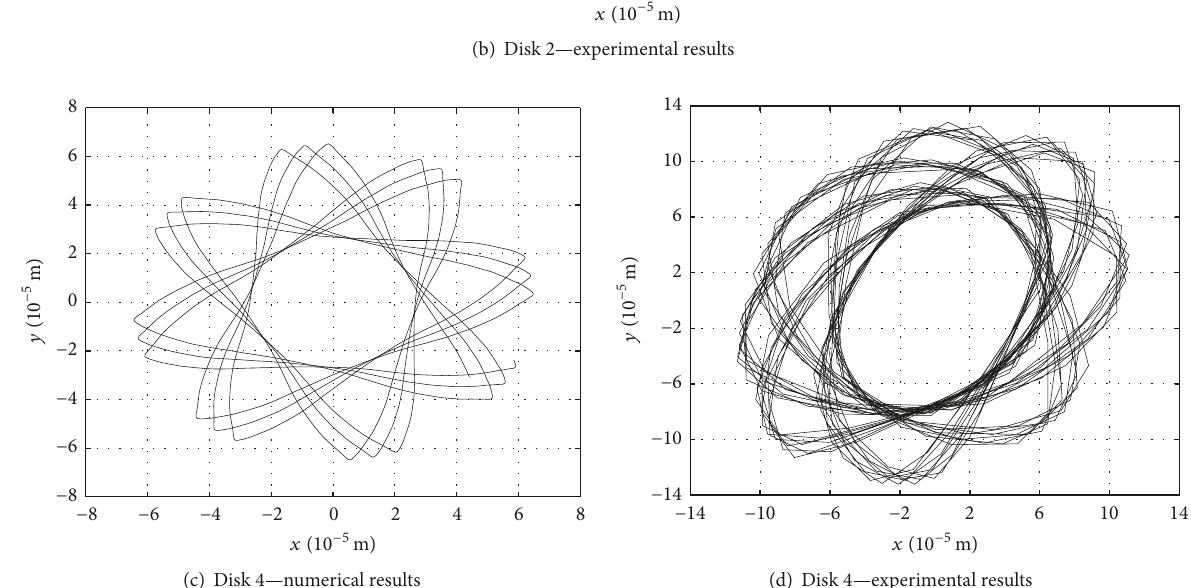
Figure 19: Orbit of disk 2 and disk 4 with 𝜔 1 = 160 rad / s and 𝜆 = −1.65